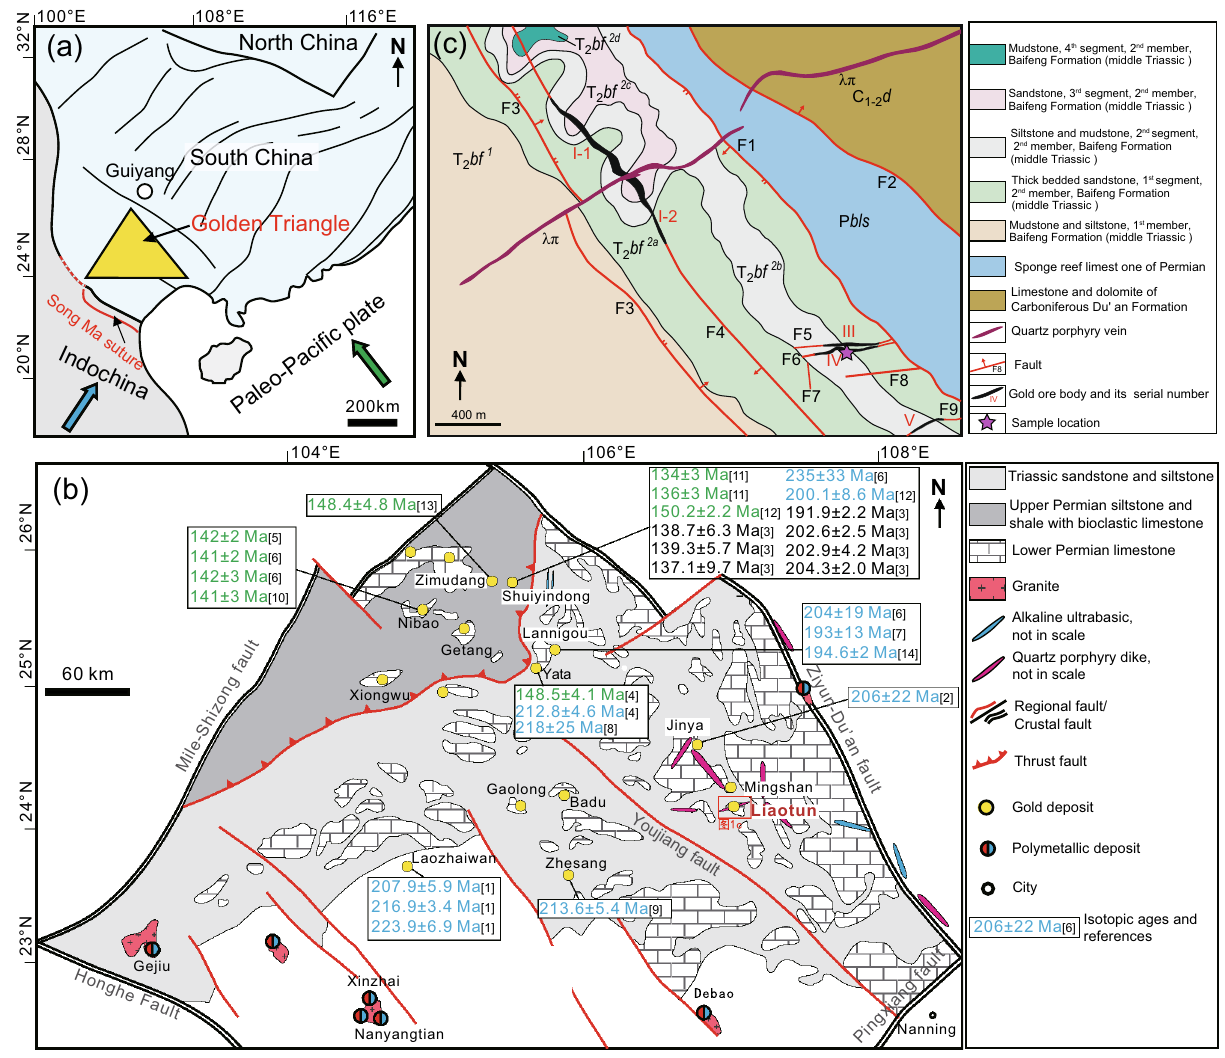
Figure 1. ( a ) Simplified geological map of the tectonic framework and location of the Golden Triangle; ( b ) Regional geological sketch map showing the distribution of gold deposits representative isotopic ages in and around the Golden Triangle and the location of the study area. ( c ) Geological map of the Liaotun gold deposit. This Figure modified after references 4 and 18 and was created using Adobe Illustrator version 2022 (https:// www. adobe. com/ produ cts/ illus trator. html), edited by Rongguo Hu. Age references: [1]- 2 ; [2]- 6 ; [3]- 4 ; [4]- 19 ; [5]- 20 ; [6]- 21 ; [7]- 22 ; [8]- 8 ; [9]- 23 ; [10]- 15 ; [11]- 24 ; [12]- 25 ; [13]- 26 ; [14]- 27